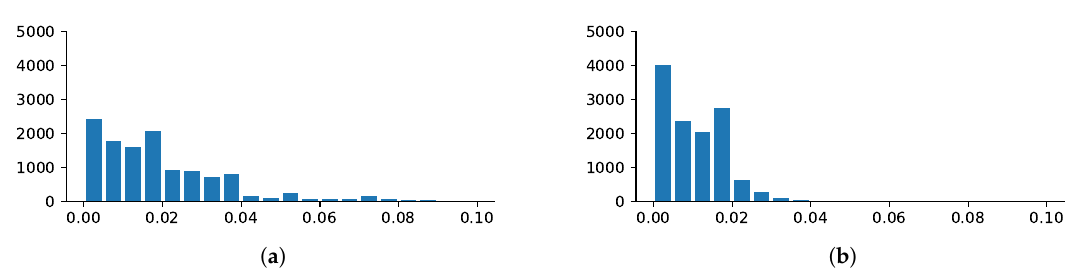
Figure 5. Residual image histograms shows that the residual error is distributed across the images. (a) Residual between cover and embedded; (b) Residual between hidden and decoded.